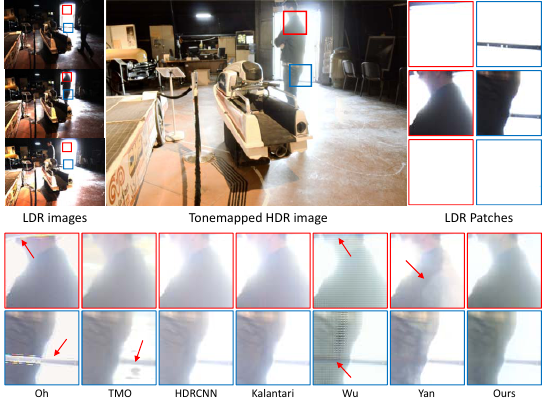
Figure 7. Visual comparisons on Tursun et al.’s dataset. In the top section, we present the input LDR images, tonemapped HDR images produced by the proposed method, and LDR image patches. In the bottom section, we compare magnified patches of the HDR images generated by our method and the state-of-the-art methods. Ground truths are not included because these datasets do not provide them. The proposed method yields plausible results without ghosting artifacts or color distortions.